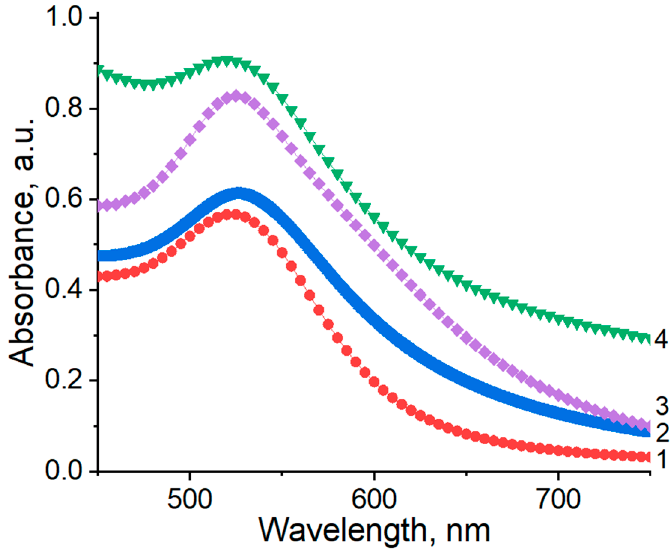
Figure 3. UV–Vis spectra of AuNPs synthesized and stabilized at 25 ◦ C using synthetic and Figure 3. UV – Vis spectra of AuNPs synthesized and stabilized at 25 °C using synthetic and natural